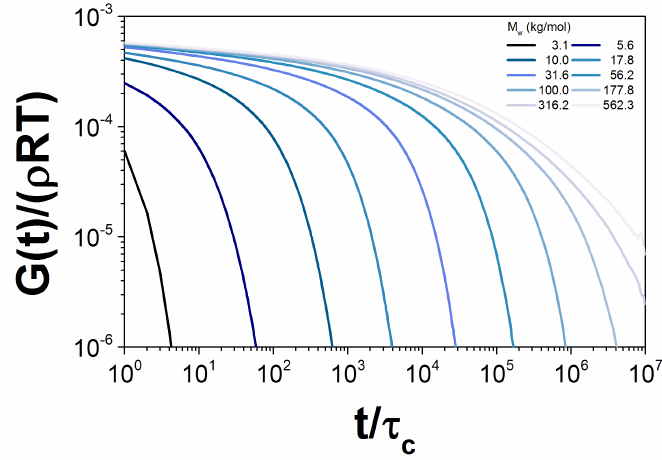
Figure 6. Normalized G ( t ) for the simulation of ten probes with different M w , corresponding to the PBD10